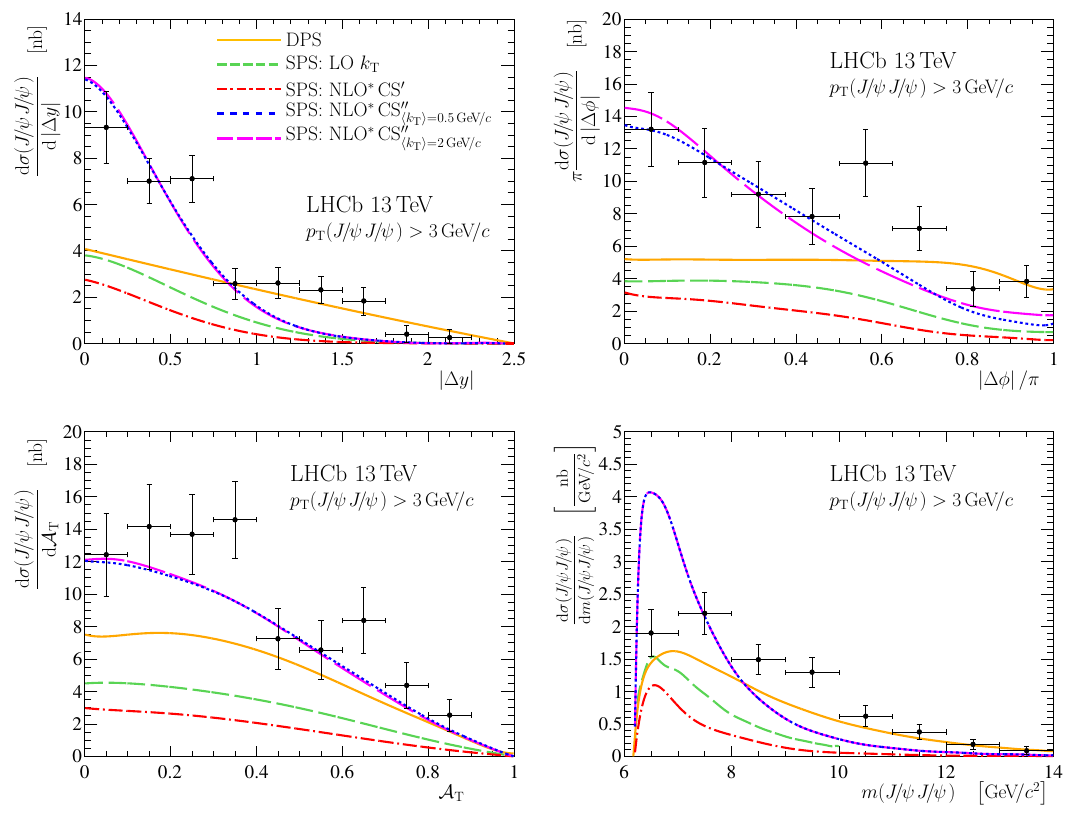
Figure 8. Comparisons between measurements and theoretical predictions with p T ( J= J= ) > 3 GeV =c for the di(cid:11)erential cross-sections as functions of (top left) tom left) and (bottom right) m ( J= J= ). The (black) points with error bars represent the A T